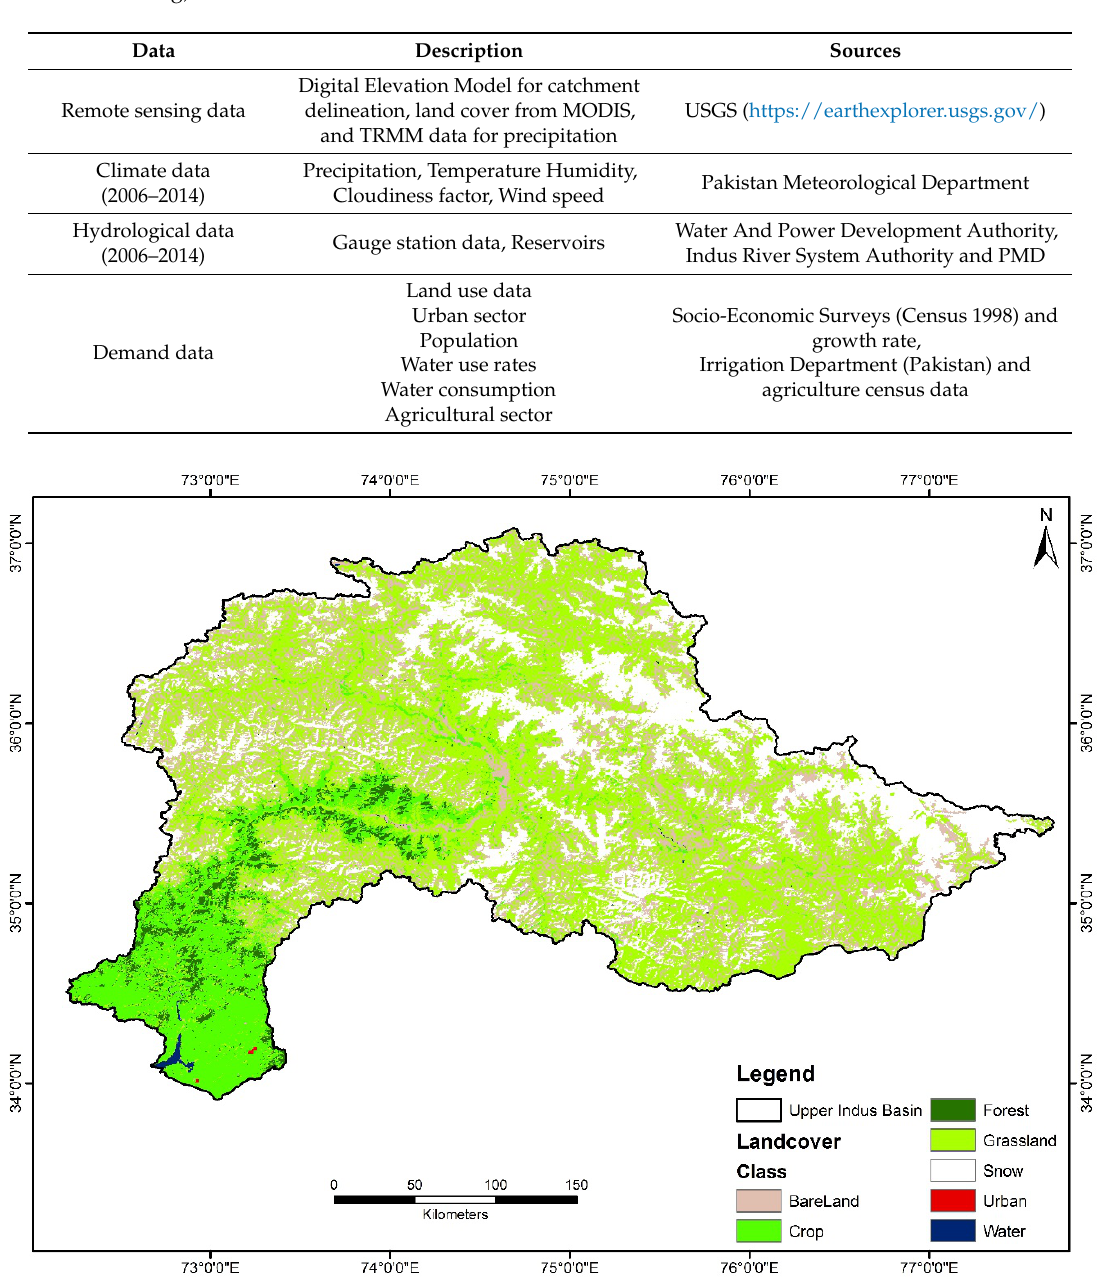
Table 1. The description and sources of the datasets used in developing the WEAP (Water Evaluation and Planning) model.